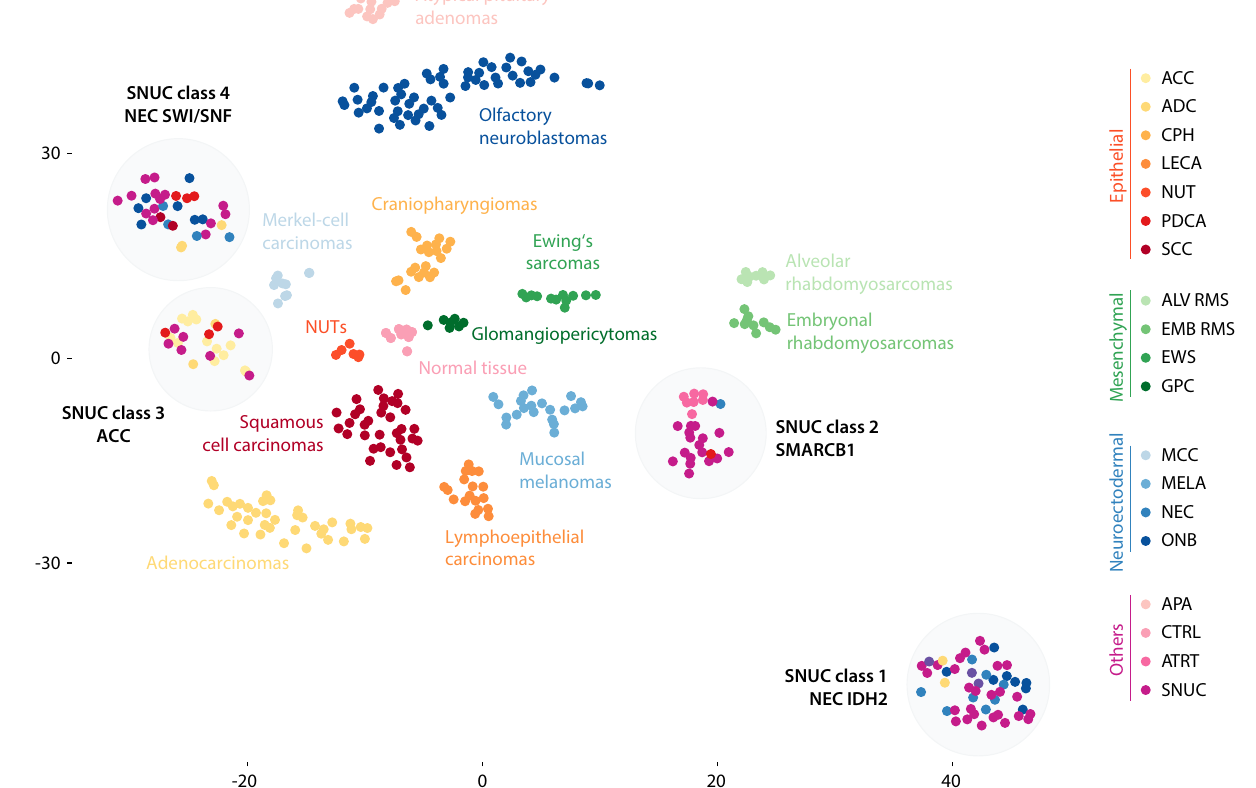
Fig. 1 | DNA methylation classes of sinonasal tumors. T-distributed stochastic neighbor embedding dimensionality reduction showing the 18 different DNA methylation classes. The conventional histopathological diagnosis is annotated by color. ACC sinonasal adenoid cystic carcinoma, ADC sinonasal adenocarcinoma, ALV RMS alveolar rhabdomyosarcoma, ATRT adult pituitary atypical rhabdoid/ teratoid tumor, CPH craniopharyngioma, CTRL normal sinonasal control tissue,